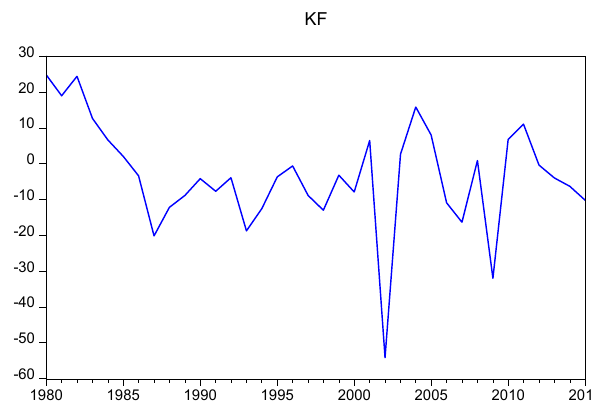
Figure A1. Botswana’s outward capital flight (KF). Positive values indicate resources leaving Botswana to other economies and less preference for domestic assets (outward capital flight). Negative values signal inward capital flight and less preference for foreign